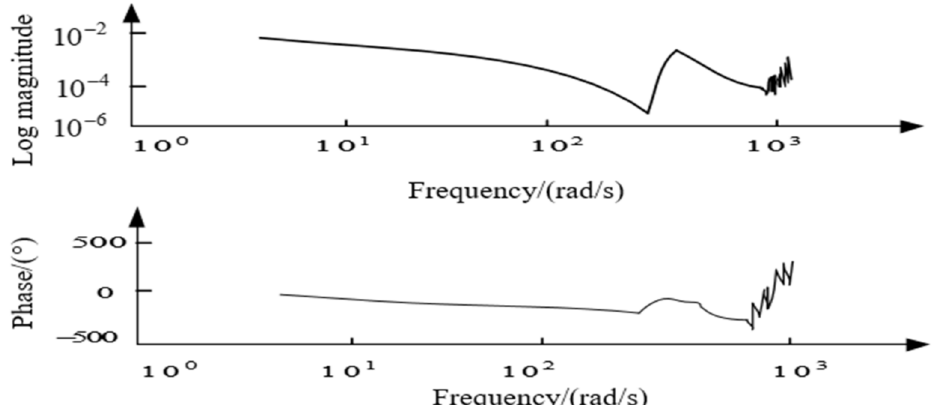
Figure 7. Scanning curve of platform model.